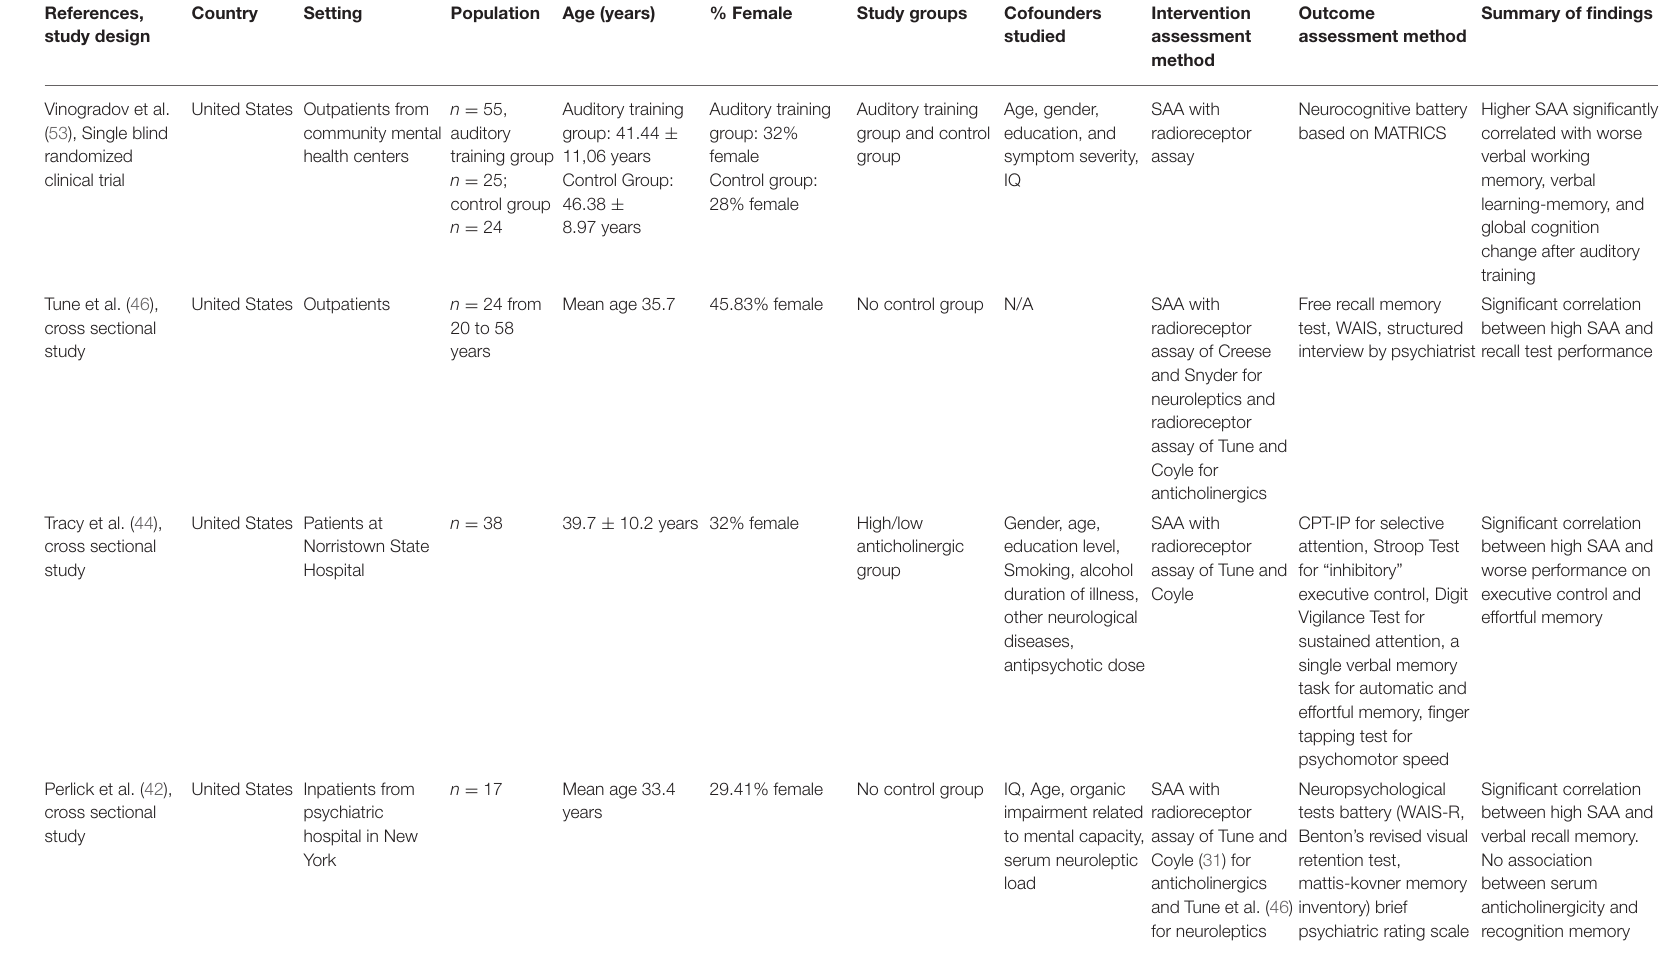
TABLE 3 | Qualitative analysis with the main characteristics of studies related to the influence of SAA on cognition in